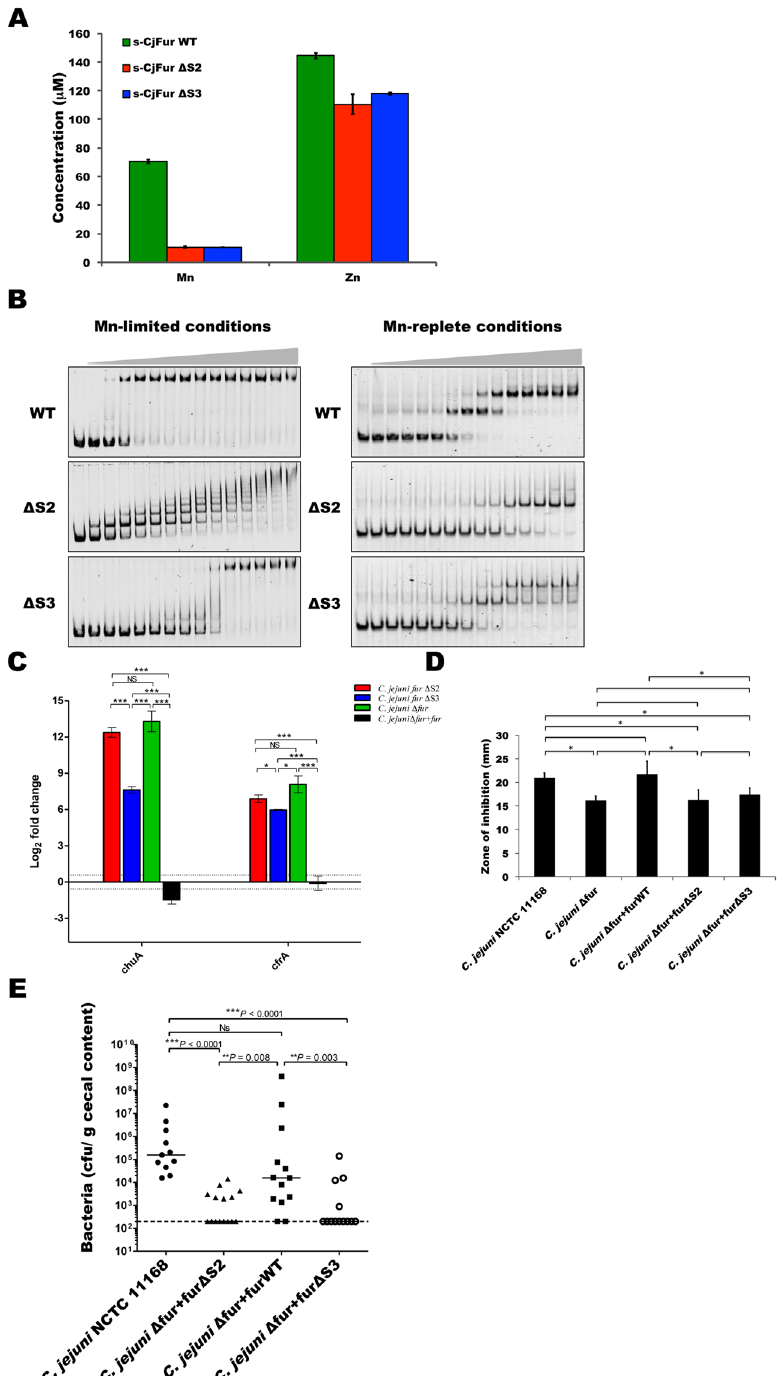
Figure 3. Role of CjFur metal binding sites. ( A ) ICP-MS metal analysis of purified recombinant CjFur, CjFur Δ S2 and CjFur Δ S3 . ( B ) EMSA of the cj1345c promoter region (2 nM) and katA promoter region (2 nM) in Mn- limited and Mn-replete conditions, respectively, with increasing amounts of CjFur, CjFur Δ S2 and CjFur Δ S3 . ( C ) RT-qPCR analysis of the expression of chuA and cfrA genes in C. jejuni Δ fur , Δ fur + fur , Δ fur + fur Δ S2 and Δ fur + fur Δ S3 strains. The expression data shown for the C. jejuni Δ fur , Δ fur + fur and Δ fur + fur Δ S2 were previously reported 51 . ( D ) Growth inhibition assay; 10 μ L of 3% H 2 O 2 was used, and the results were taken 28 hours post H 2 O 2 exposure. The assays were performed in triplicate using three biological replicates. The statistical significance was determined using the Student’s t-test. P values < 0.05 were considered significant. ( E ) Campylobacter jejuni wild type, complemented WT, Δ S2 and Δ S3 colonization levels in the chick cecum. Each data point represents the cfu per gram of cecal content recovered in each